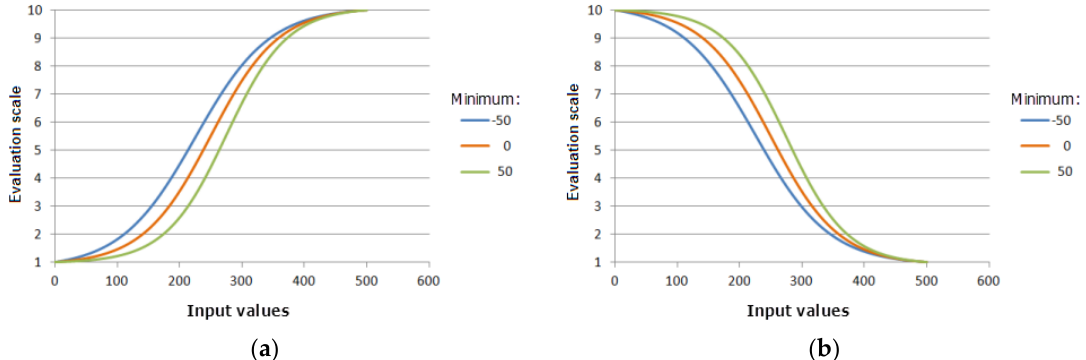
Figure 1. Logistic functions.